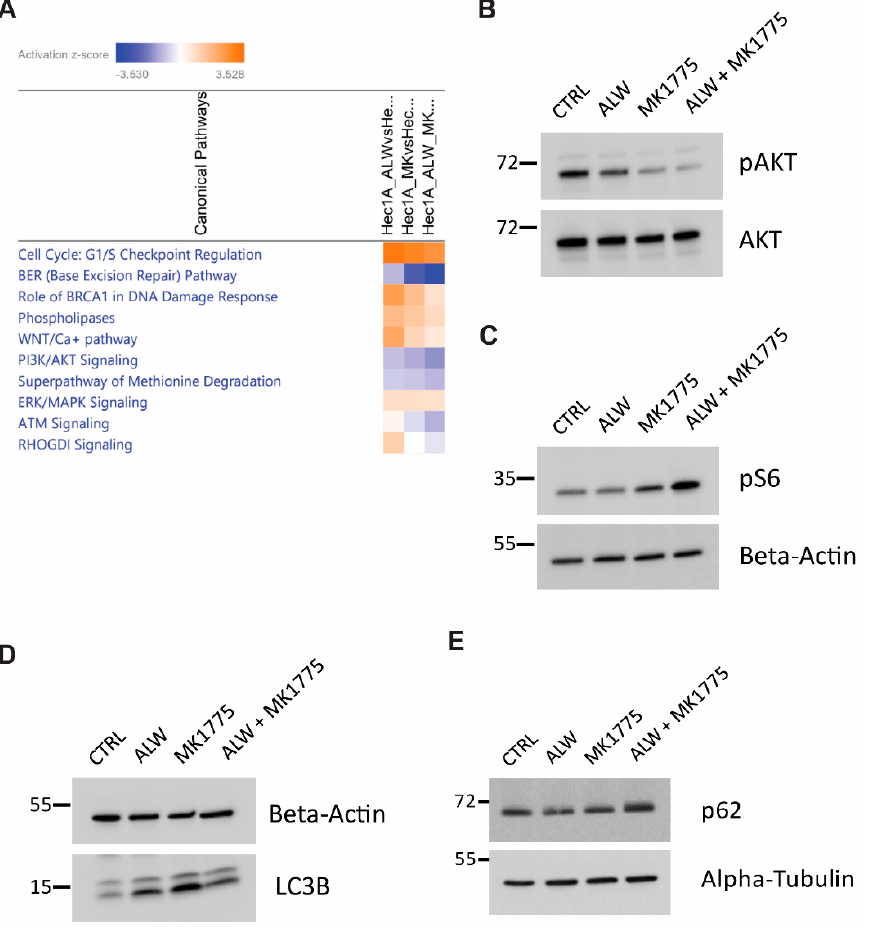
Figure 5. IPA analysis for identification of molecular mechanisms associated with synergy of EphA2- and Wee1–targeted therapy. ( A ) Comparative analysis of pathways downregulated in combination therapy. ( B , C ) Validation of RNA–Seq analysis of AKT pathway repression ( B ) and mTOR pathway activation ( C ). ( D , E ) Validation of RNA–Seq analysis with autophagy marker LC3B ( D ) and autophagy substrate p62 ( E